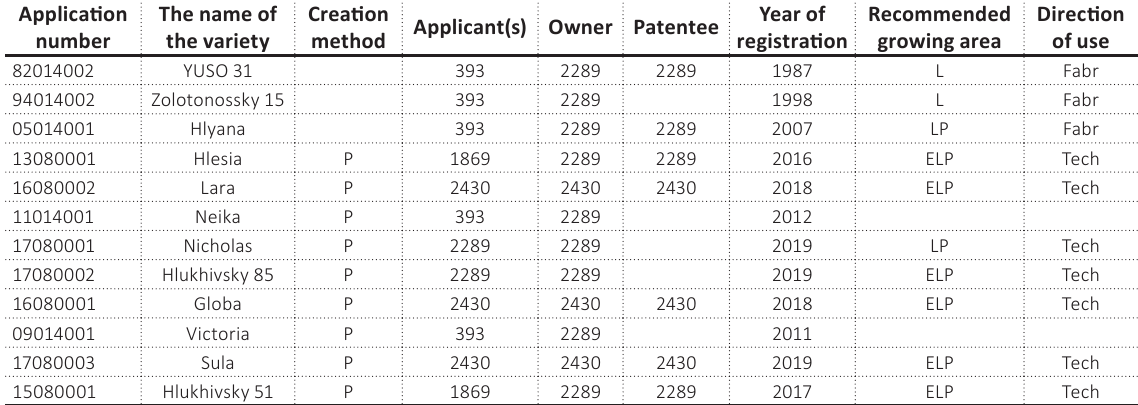
Table 1. Data from the State Register of Industrial Hemp Varieties as of December, 2019 Source: Based on the Ukrainian Institute for Plant Variety Examination (UIPVE)